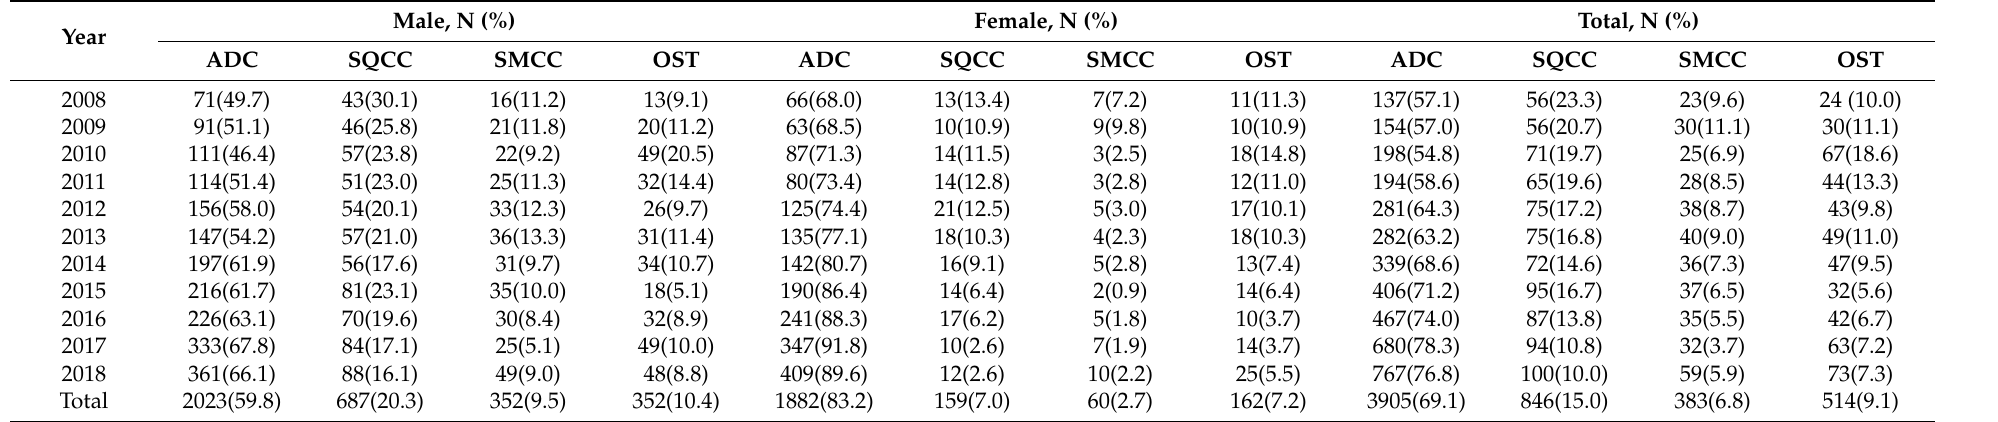
Table 2. The distribution of lung cancer by histological type in Shenzhen,